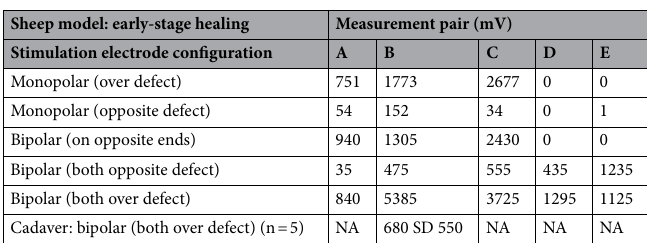
Table 2. Summary of electric potential at fracture site in